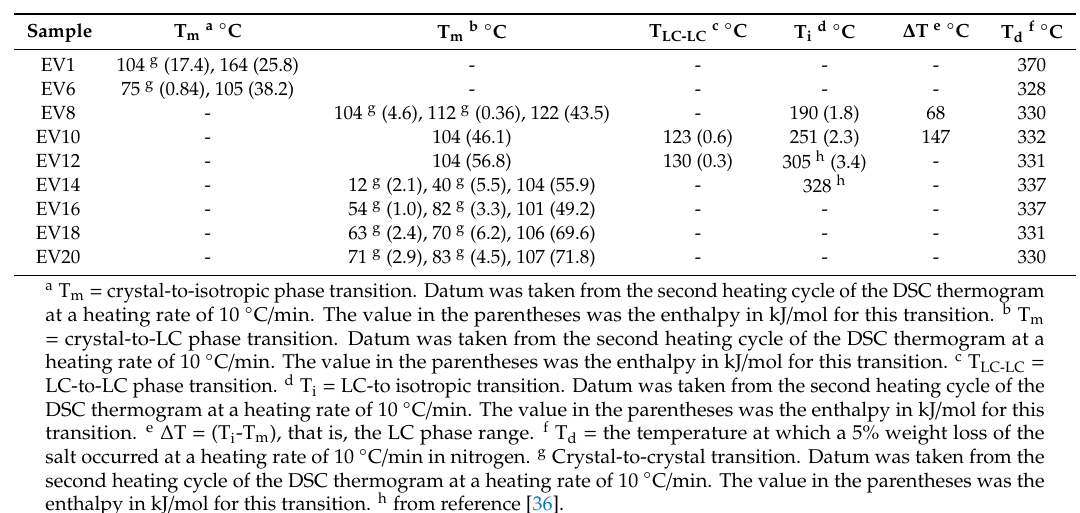
Figure 10. Optical textures of EV16, EV18, and EV20 taken at ( a ) 240, ( b ) 150, and ( c ) 290 °C, respectively, displaying SmA phases (magnification 400×). Table1. Thermodynamicpropertiesofphasetransitiontemperaturesofextendedviologenbis(triflimide) salts (EVn) obtained from DSC measurements and decomposition temperatures obtained from thermogravimetric analysis (TGA)